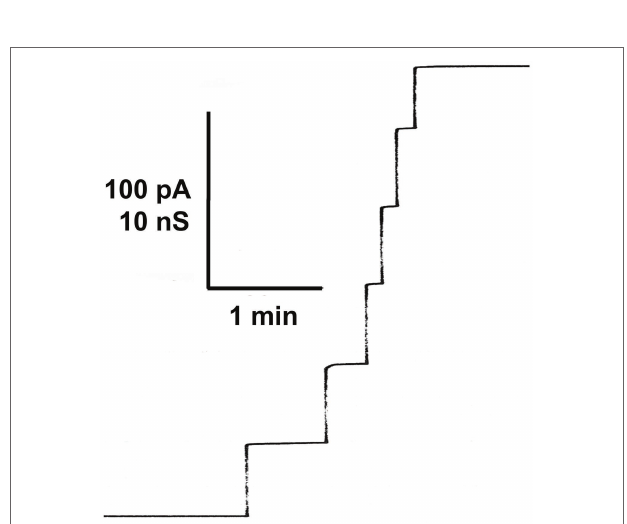
FIGURE 3 | Semilogarithmic plot of the ratio, N0/Nc , as a function of the transmembrane potential V m . The data were taken from Figure 2 . The slope of the straight lines is such that an e-fold change of N0/Nc is produced by a change in V m of 12.5 mV (left side) and 11.9 mV (right side), corresponding to gating charges, n = 2.0 and 2.1, respectively. The midpoint potential of the N0/Nc distribution (i.e., N 0 = N c ) was at 27.4 mV (left side) and 35 mV (right